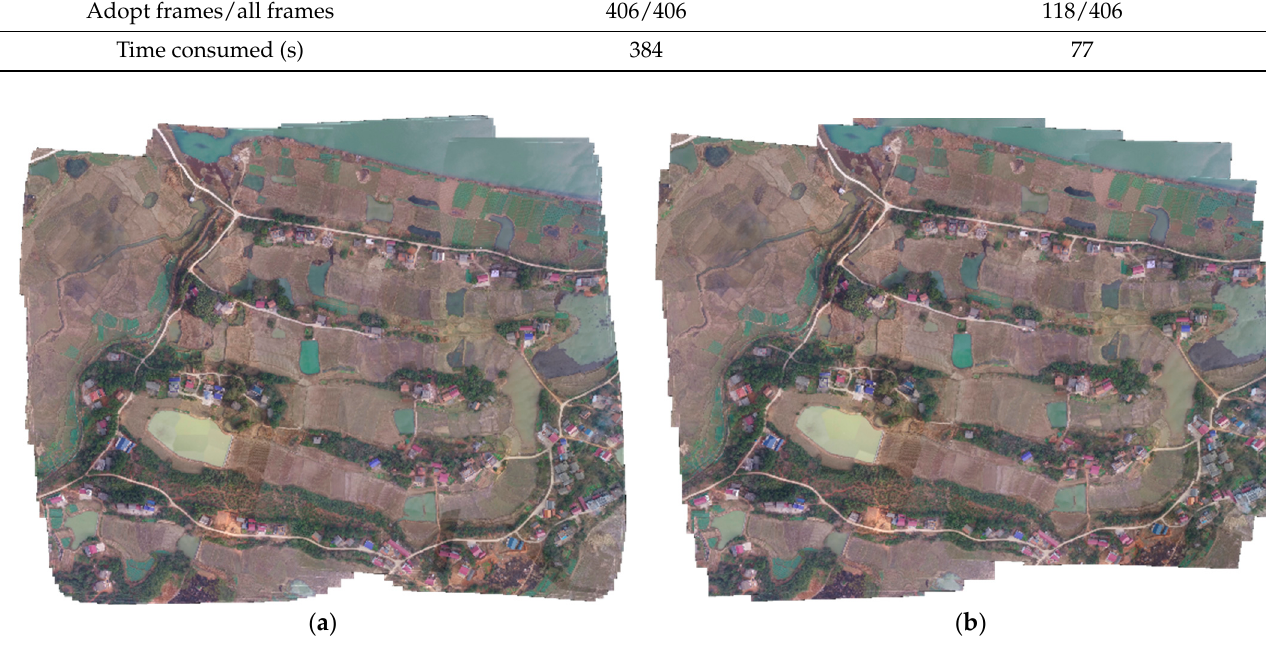
Figure 12. Comparison of full frame mosaicking and keyframe selection mosaicking. ( a ) Full frame mosaicking. ( b ) Keyframe selection